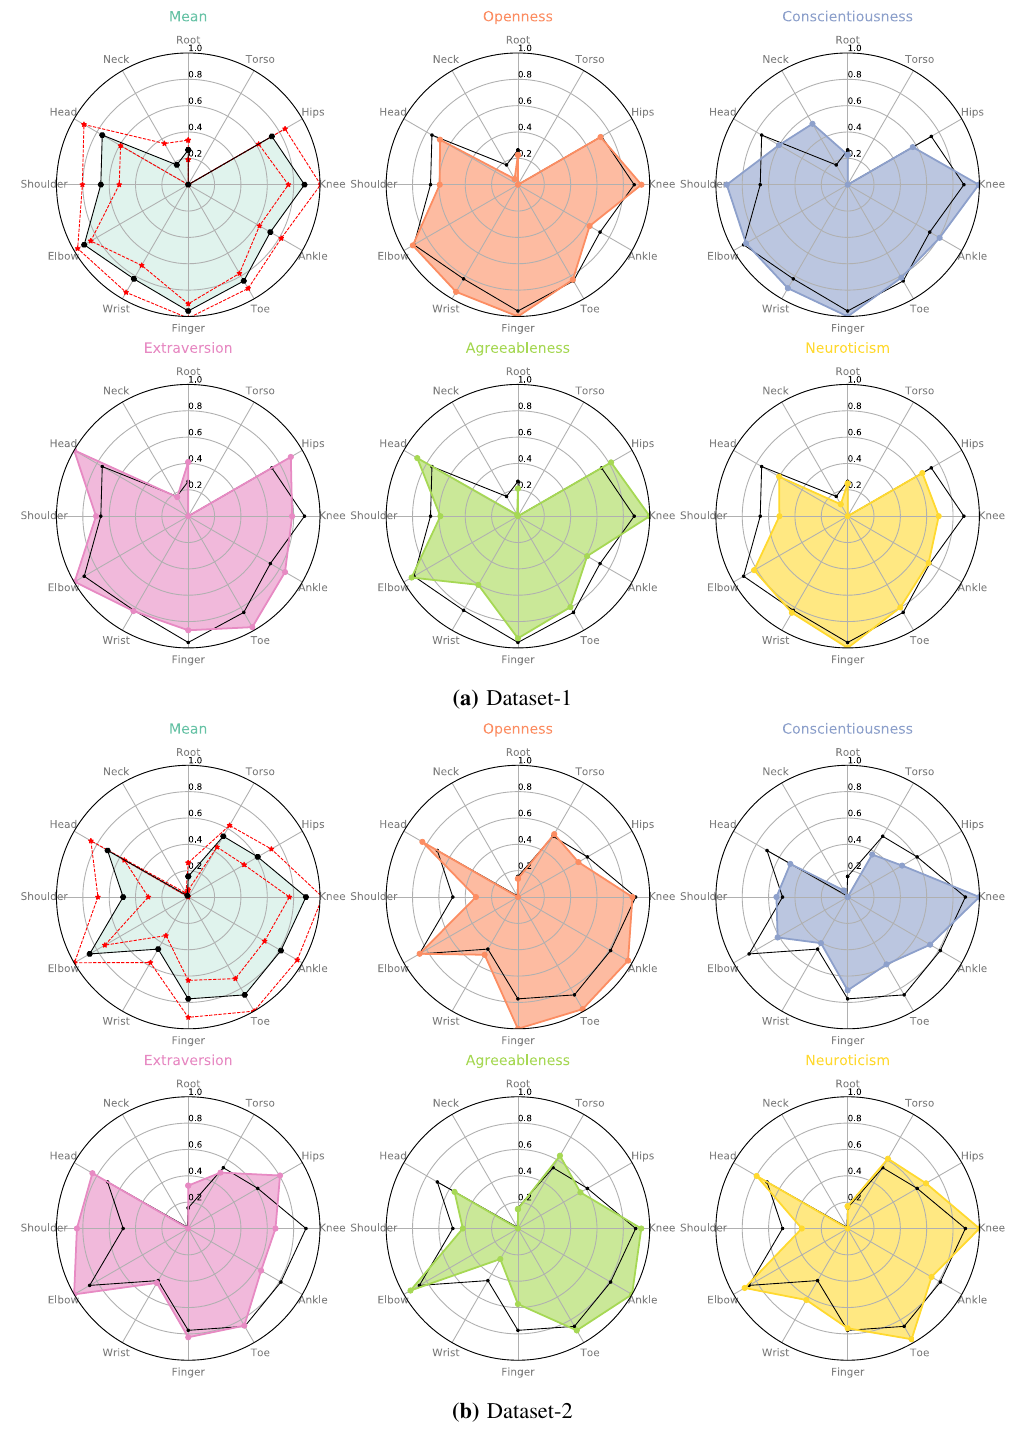
Figure 1. Relative importance of Joints of the five personality traits (Openness, Conscientiousness, Extraversion, Agreeableness, and Neuroticism) using the Position Data. The black line indicates the mean importance of the corresponding joint marker. The red dotted line in the top left sub-figure indicates the standard deviation about the